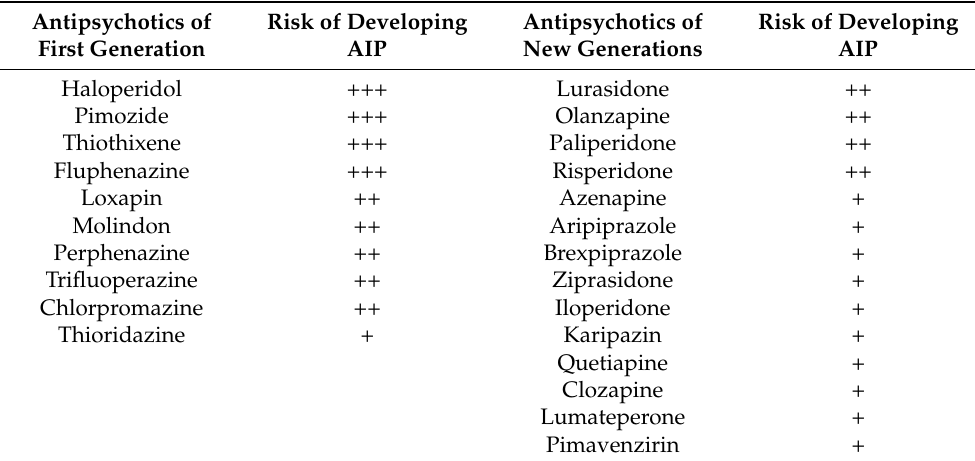
Table 1. The risk of developing parkinsonism induced by taking antipsychotics of the first and new generations.